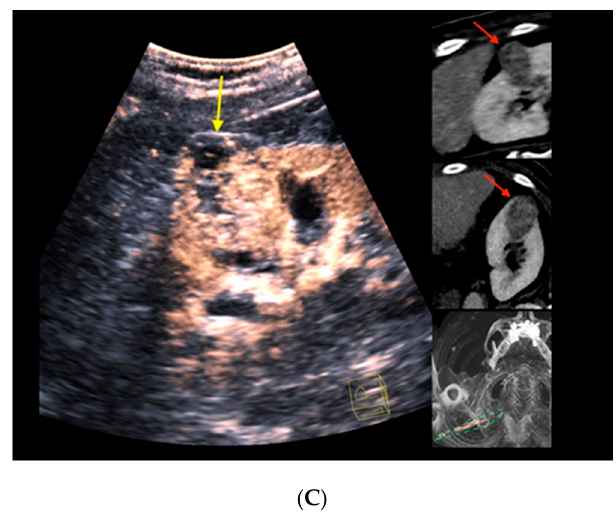
Figure 2. Real-time CT-/CEUS-fusion imaging of a complex renal cystic lesion. ( A ) Known complex renal cystic lesion with indicated septations and solid components in the right kidney from previous contrast-enhanced CT (left, red arrow) is displayed in a side-by-side mode with native B-mode (right, yellow arrow) by a high-end ultrasound system. ( B ) Additional Color Doppler did not reveal hypervascularization of the lesion (yellow arrow). The software interface of the ultrasound device showed four different images: the real-time Color Doppler image (left, maximized), the CT imaging dataset in sagittal (upper right) and axial (middle right) reformation (lesion marked by red arrows), and a real-time 3D navigation of the Fusion Imaging (lower right). ( C ) Contrast-enhanced ultrasound allowed for visualization of early arterial microperfusion of solid components of the lesion, implicating malignancy (left, maximized), (lesion marked by red arrows in corresponding CT images). The patient underwent partial nephrectomy. Histopathology, finally, revealed underlying clear-cell renal cell carcinoma.